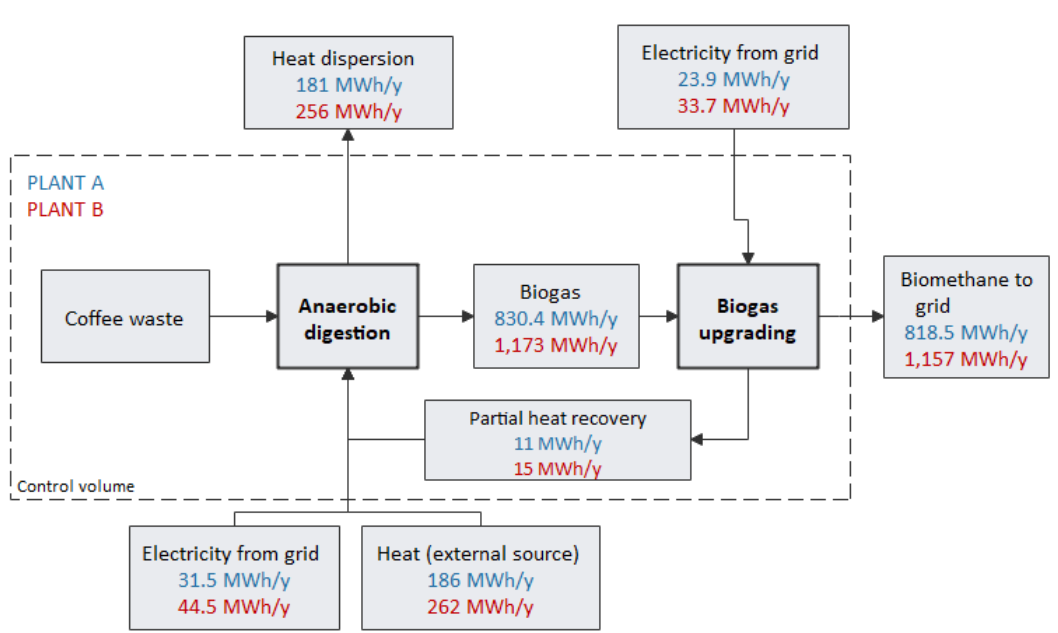
Figure 4. Energy balance of Plant A (in blue) and Plant B (in red).